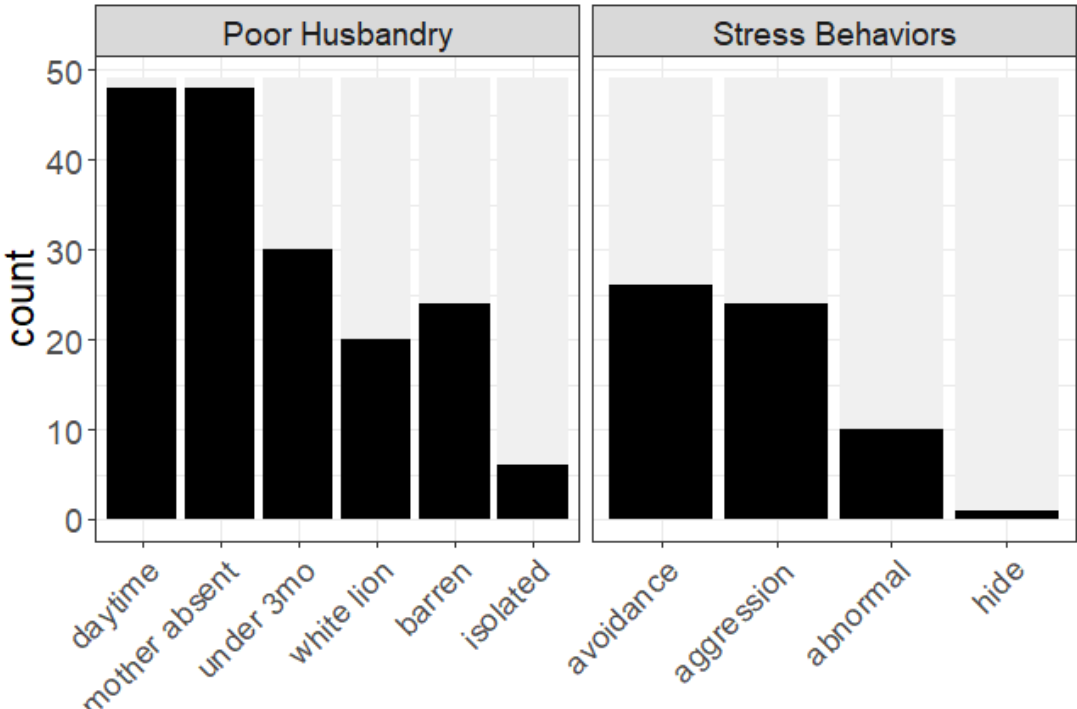
Figure 1. Videos characteristics. The black bars represent the number of videos ( n = 49) that showed each of six poor husbandry practices and four cub stress behaviors (see Table 1 for definitions).